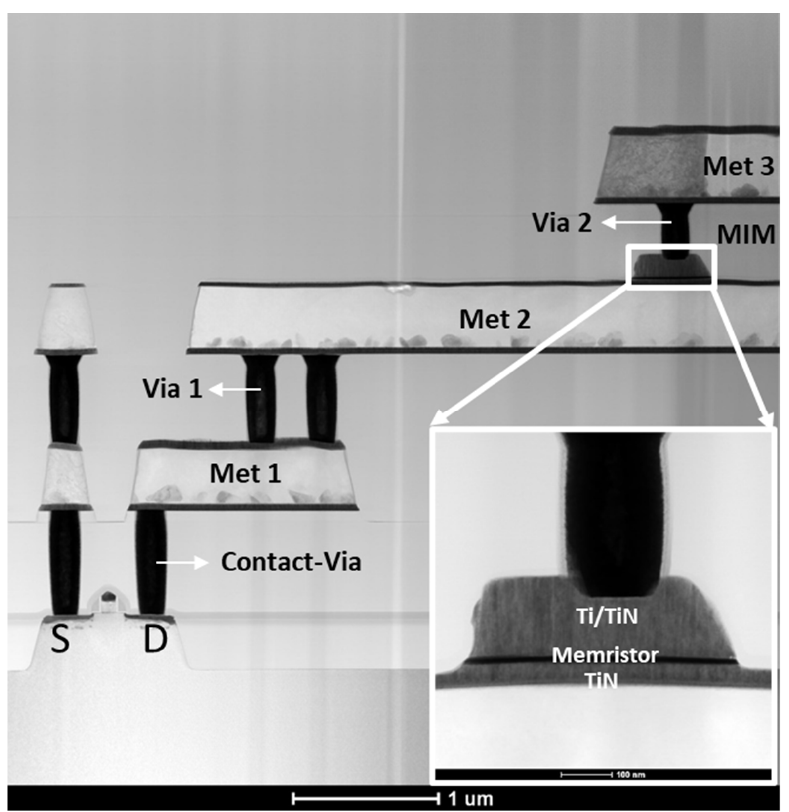
Figure 1. TEM cross-section of an integrated 1T–1R memristor device, fabricated in 130 nm CMOS technology. The inset micrograph illustrates the memristor module.